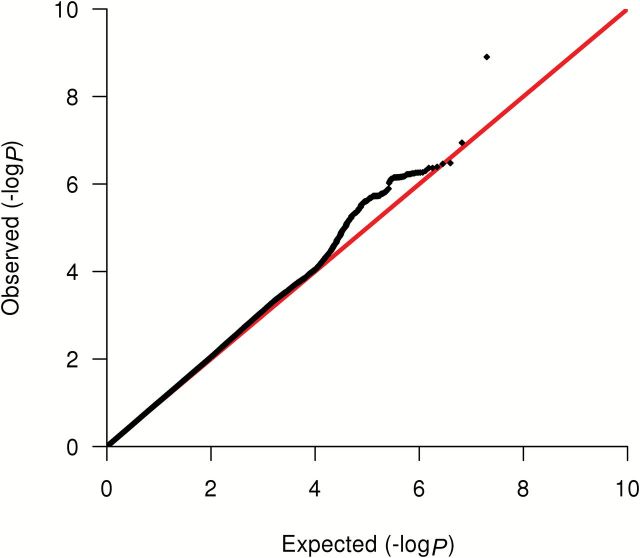
Quantile-Quantile (Q-Q) plot for the combined GWAS and COGS analyses for estrogen receptor (ER)–negative cases. The y-axis represents the observed -log10
P value, and the x-axis represents the expected -log10
P value. The red line represents the expected distribution under the null hypothesis of no association. All statistical tests were two-sided.